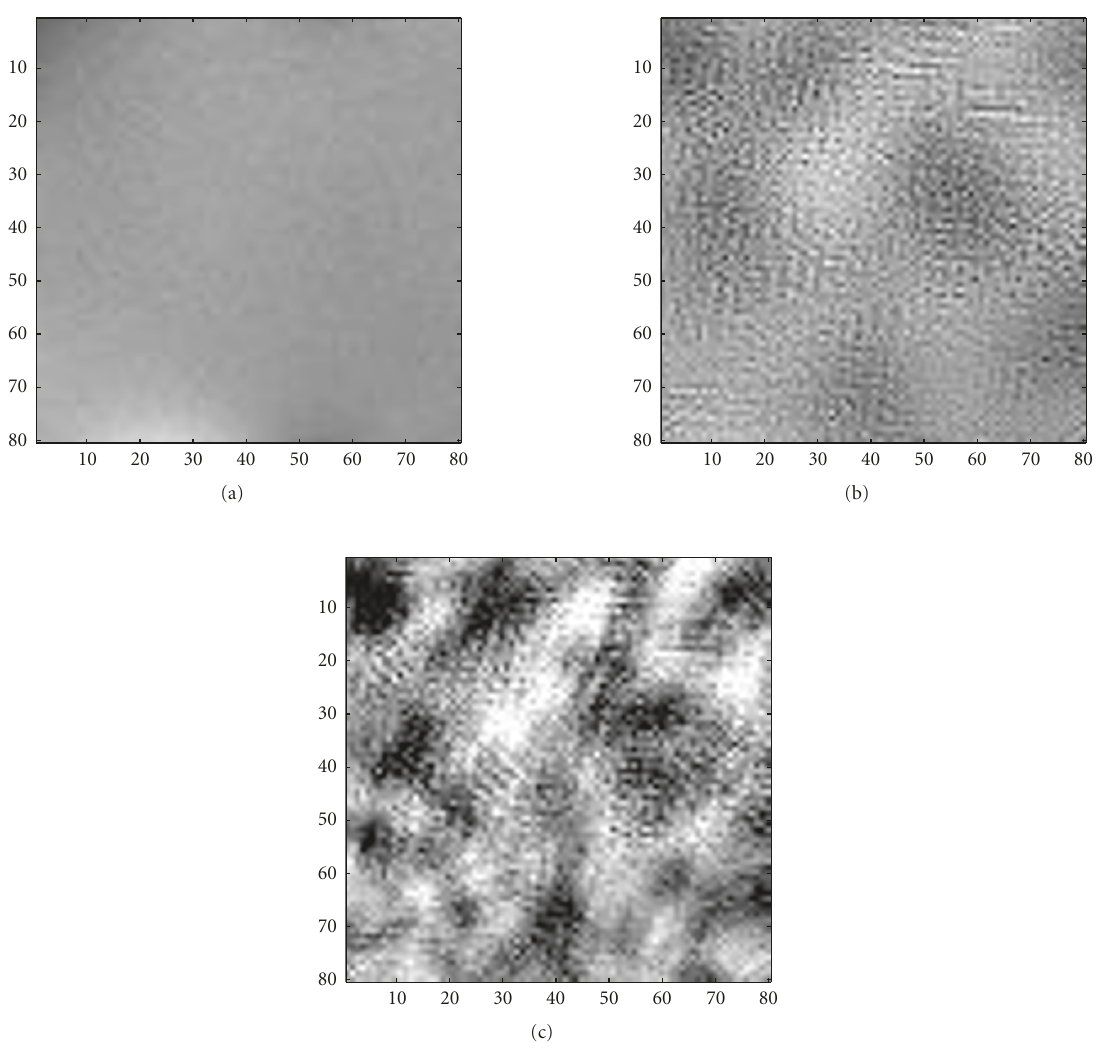
Figure 6: Bias error image for P = 30: (a) Joint MAP SR-NUC bias error image; (b) MAP NUC bias error image; (c) registration-based NUC bias error